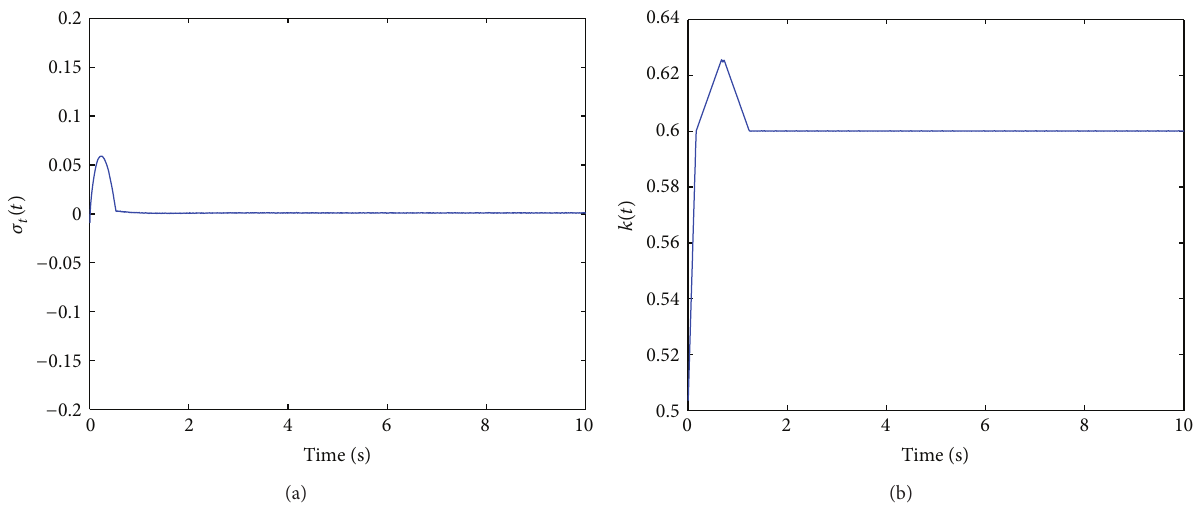
Figure 6: (a) Sliding surface function with TPAISMC ( 𝜎 -adaptation). (b) Adaptive gain parameter ( 𝜎 -adaptation).